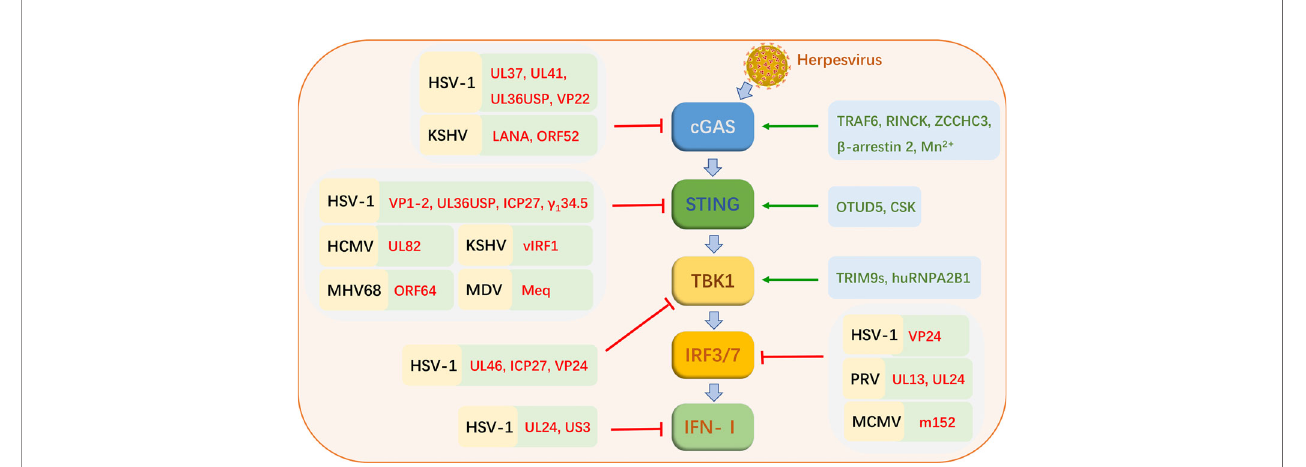
FIGURE 2 | Strategies of cGAS-STING signaling pathway activation and virus evasion during herpesvirus infections. Black letters represent herpesviruses. Red letters indicate the proteins of these viruses. Green letters indicate cellular proteins that favor cGAS-STING signaling pathway